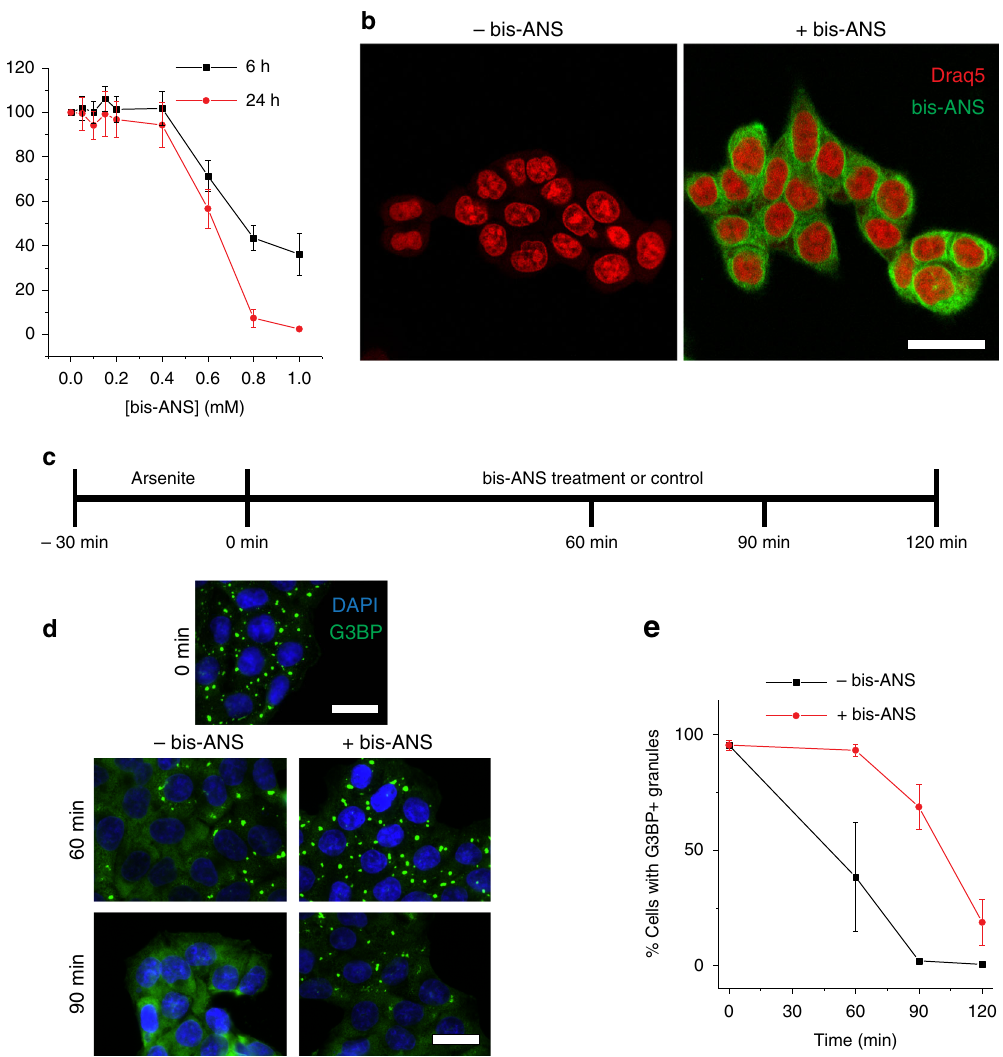
Fig. 7 Bis-ANS modulates stress granule dynamics in cells. a HCT-116 cell viability upon treatment with increasing concentrations of bis-ANS for 6 or 24 h as determined by 3-(4,5-dimethylthiazol-2-yl)-2,5-diphenyltetrazolium bromide (MTT) assay. Error bars represent SD ( n = 5 technical replicates across two biological replicates). b Live-cell imaging of HCT-116 cells with or without 1 h treatment with 250 μΜ bis-ANS. Nuclei were stained with